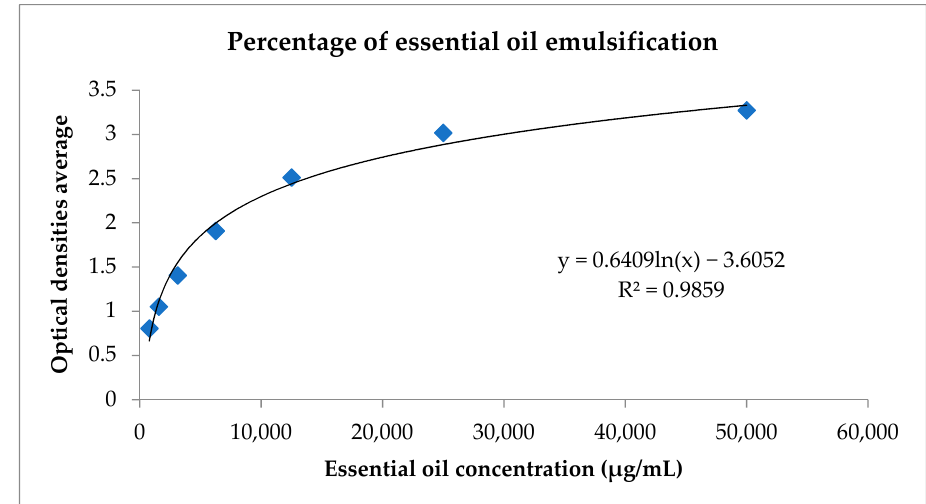
Figure 1. Logarithmic regression to calculate the percentage of emulsification of C. cajucara essential oil. Standard curve of the C. cajucara essential oil compared with ultrasonicated Pluronic ® F-127 and the NEs. The percentage of essential oil in nanoemulsion was based on the equation obtained through logarithmic regression.